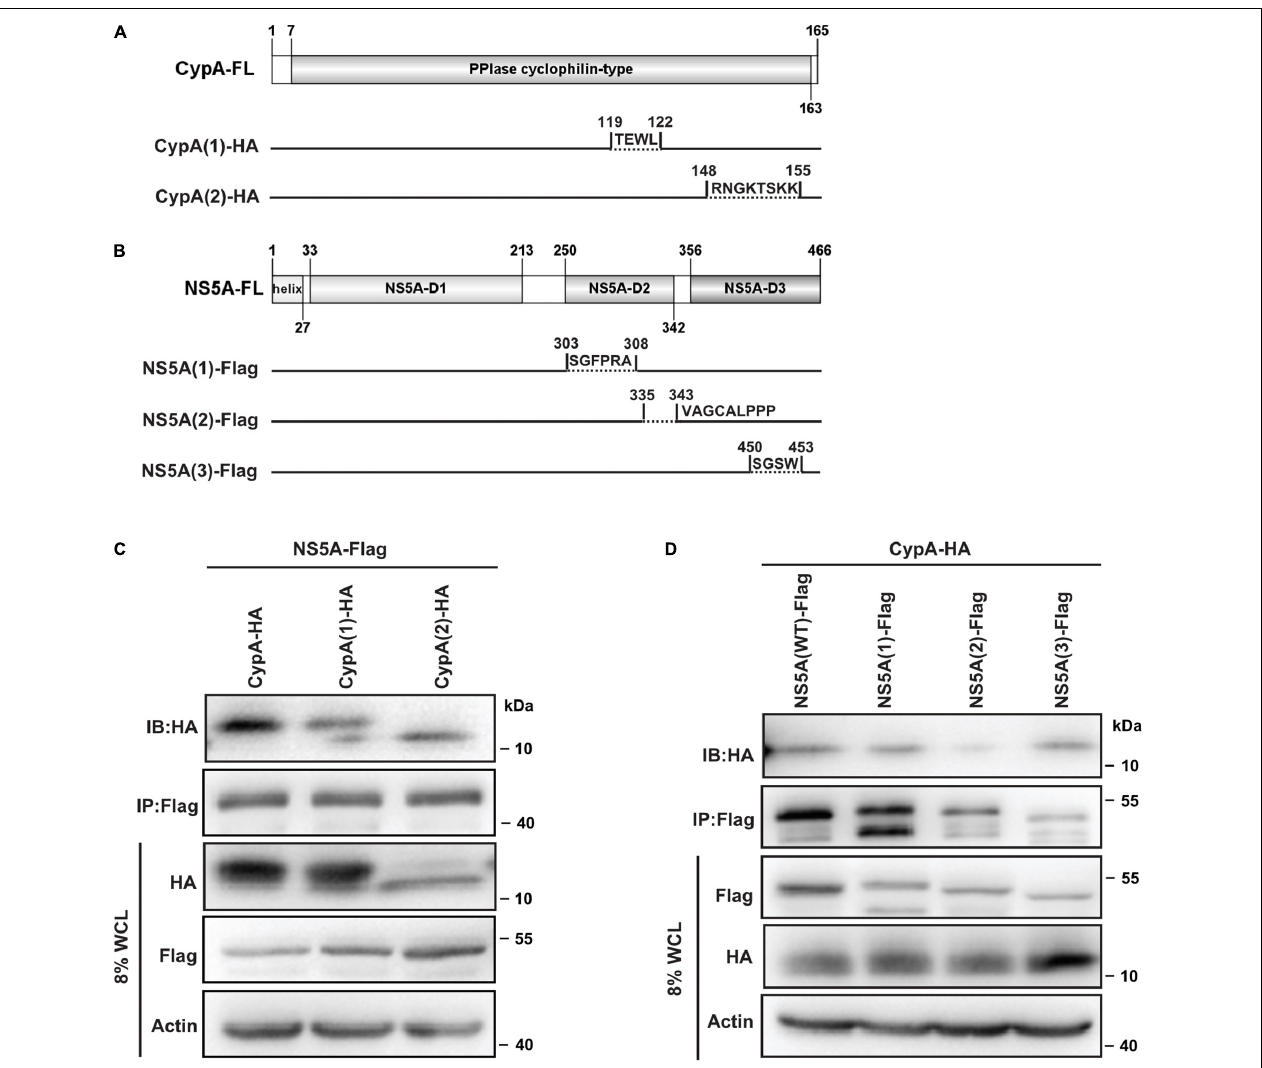
FIGURE 5 | Validation of the predicted CypA–NS5A interaction. (A,B) Schematic representation of CypA and NS5A truncations. Diagrams were constructed using IBS (version 1.0) (Liu et al., 2015). The interactions of NS5A with CypA truncations (C) and that of CypA with NS5A truncations (D) were detected by IP with anti-Flag antibody followed by immunoblotting (IB) with anti-HA antibody in HEK293T. Data are representative of three independent experiments. CypA, cyclophilin A; NS5A, non-structural protein 5A; IP,